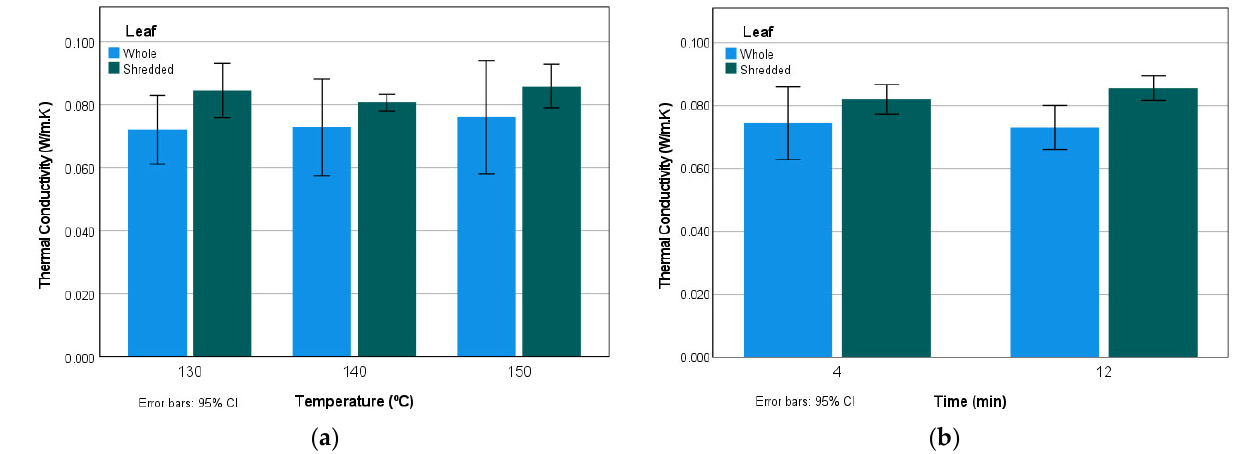
Figure 10. Thermal conductivity according to ( a ) temperature and ( b ) pressing time.